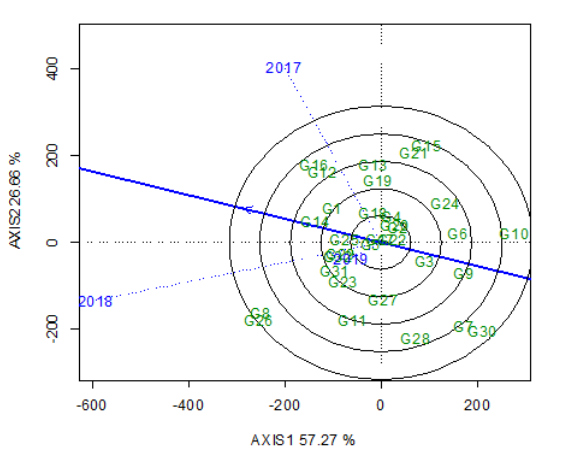
Figure 2 Discriminativeness vs. representativeness of the three evaluated cropping seasons. The first two main factors (components) of the biplot analysis applied to Genotype × Environment interaction effects explained 83.9% of the total variation. Environments 2017 and 2018 were positively correlated (acute angle) and 2018 and 2019 were highly correlated, whereas 2017 and 2019 were uncorrelated (right angle).